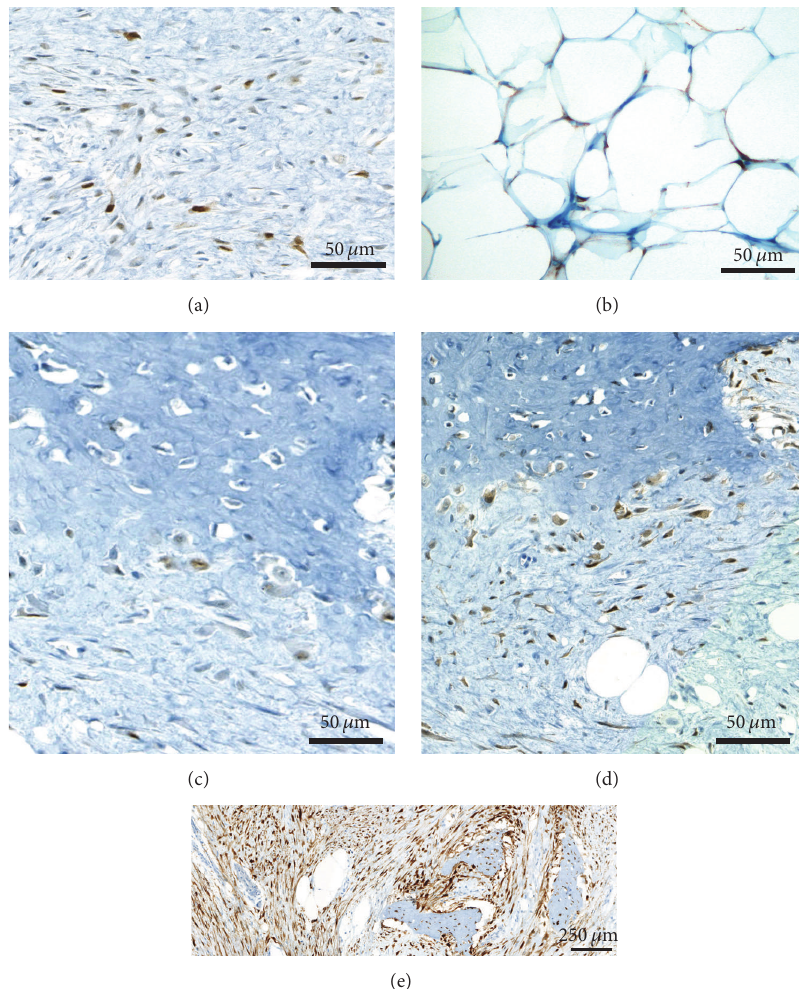
Figure 4: Immunostaining of MDM2, CDK4, and P16: (a), (b), and (c) Immunostaining with anti-MDM2 antibody. MDM2 nuclear positivity is present in 5–10% of stromal cells (a), in some lipoblasts (b), and in rare osteoblasts rimming neoformed bone (c). (d) Immunostaining with anti-CDK4 antibody: more diffuse nuclear but also cytoplasmic staining was present in stromal cells and osteoblasts (20–30%). (e) Immunostaining with anti-P16 antibody: albeit not specific, diffuse and strong positivity with P16 was present in stromal cells, cells rimming or within bone trabeculae and also in